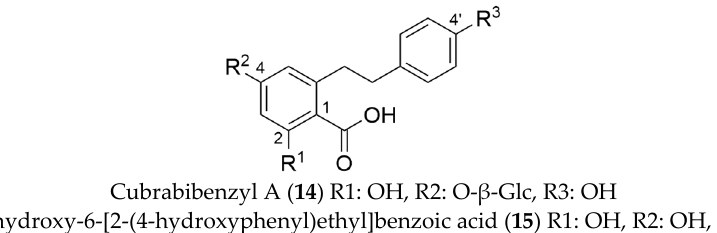
Figure 5. Molecular structures of dihydro-stilbenic acids isolated from Hydrangea macrophylla ssp. serrata.